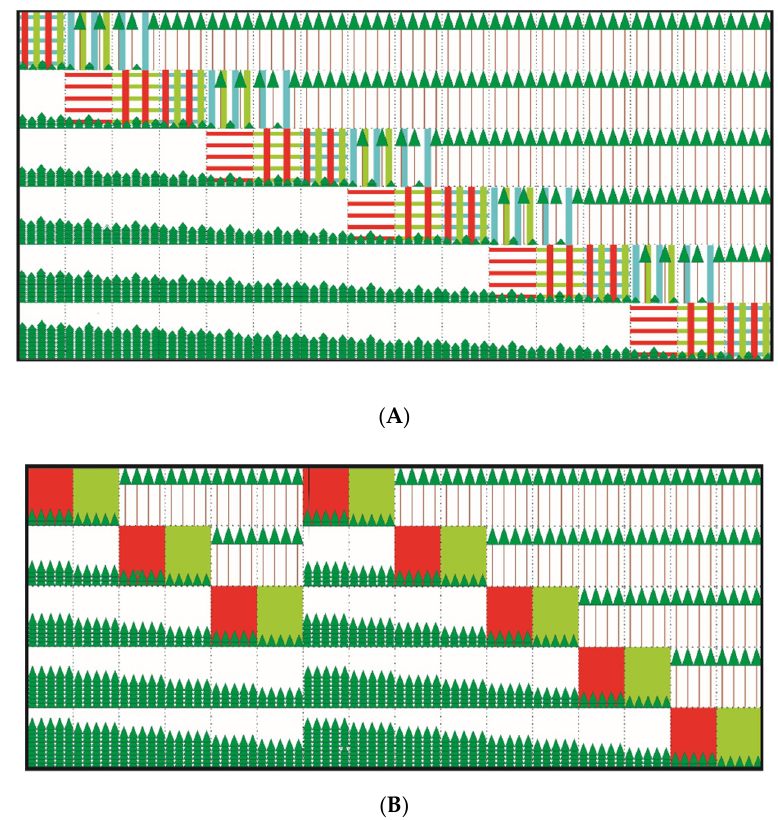
Figure 2. Schemes of an expanding small-scale shelter-wood with 3 phases per decade and 60 year-long regeneration period ( A ), and a small-scale clearcutting scenario with 2 cuttings per decade and 50 year-long regeneration period ( B ) as examples of the predefined harvest-regeneration variants simulated in SIBYLA. Each row represents one decade of the regeneration period and applied cuttings within a 16 ha large forest stand divided into 16 regeneration elements. Coloured stripes in A represent cutting phases of the shelter-wood system, while vertical stripes of di ff erent color represent preparatory and seeding cuts, and horizontal stripes represent final cut of the respective regeneration element. Red and green colored elements in B represent stand parts, where first and second clearcuttings took place in 1st and 5th year of the decade, respectively.